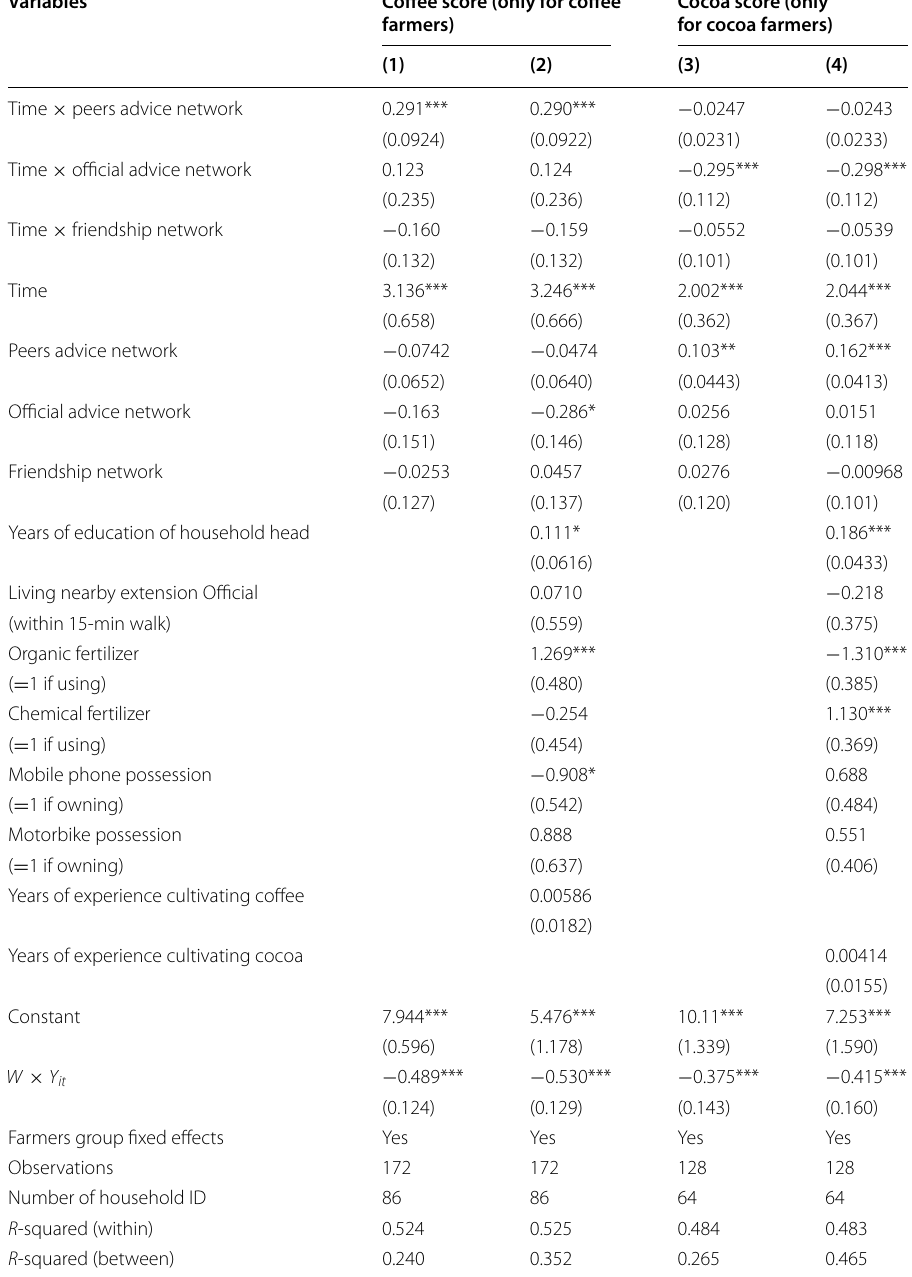
Table 8 Effects of personal network on knowledge